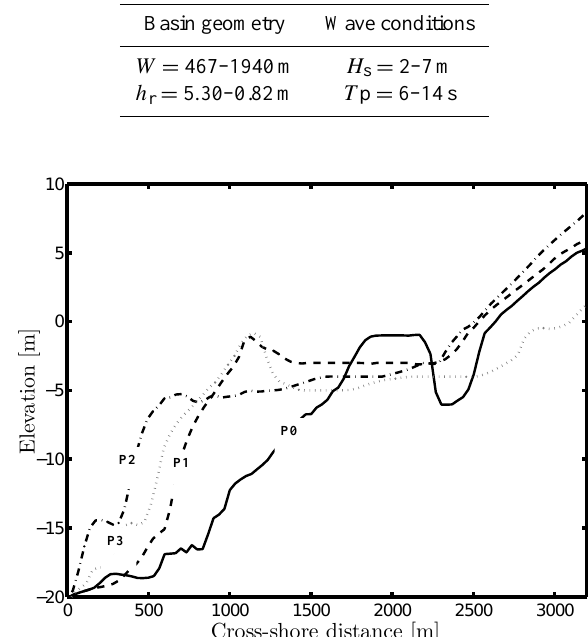
Table 5. Range of the reef geometry and the wave conditions pa- rameters employed for the simulated cases.